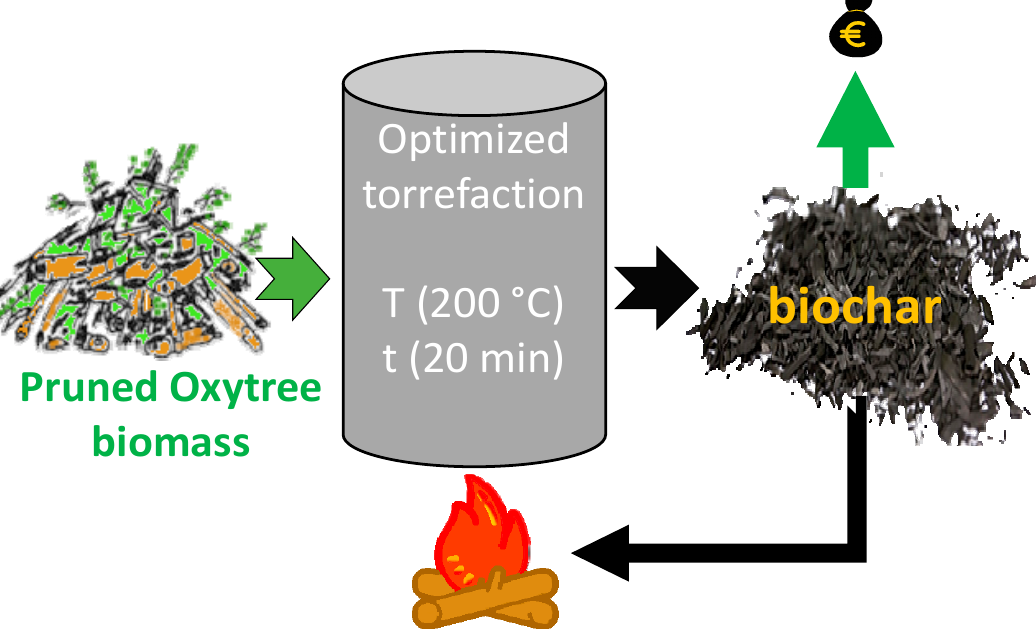
Figure 18. Graphic presentation of the benefits of the pruned Oxytree torrefaction concept.